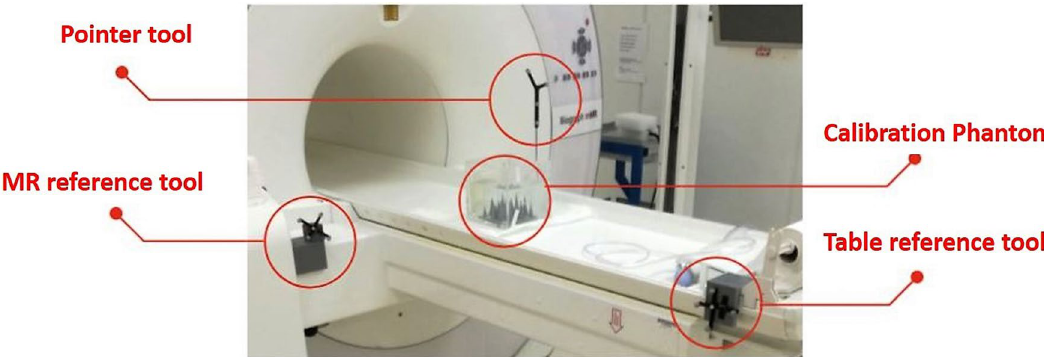
Figure 3. Set-up of the MR calibration. The coordinates of the calibraion phantom are measured respect to the ORF MR MR reference tool with a calibrated pointer tool. This enables to determine the transformation T MR from the MR-image coordinate system to the coordinate system of the optical tool mounted on the gantry of the using a calibrated stylus. In order to minimize the jitter-error from the stylus measurements, each of the seven cone tips were measured 10 times adjusting the relative camera position 10 times. Seventy points, acquired on a second multi-cone phantom, from independent ten images taken from different camera positions were used to compute the TRE. To increase accuracy we introduced an additional phantom calibration 19 . The coordinates of the cone tips were gathered in the coordinate system of the tank reference system as well as in the coordinate system of the CAD model of the phantom . This resulted in a transformation which was used to re-calculate the coordinates of the fiducials in the reference system from the more precisely measurable points in the CAD volume. For the TRUS calibration a point-to-point registration was applied as described in the 3D Slicer tutorial 20 . The TRUS transducer was mounted in a fixed position upon an empty water tank and a calibrated pointer was swept within the US image field of view (FOV). Tracker data were recorded automatically and the corresponding image coordinates were determined by marking at the maximum intensity profile of the pointer tip on the image for certain time points. The list of fiducials (15 fiducials on the 2D-TRUS image) given in the two coordinate systems (i.e. the image and the OTS coordinate system) were then used for the point-to-point registration. MR calibration. The MR calibration was carried out by a point-to-point registration to get the transformation ORF MR ) and the MR image ( MR ). To measure the coor- T MR ORF MR between the OTS reference coordinate systems ( dinates of the phantom tips with respect to the OTS two optical tracking tools were mounted rigidly on the MR gantry and on the MR table (see Fig. 3, labeled as ’MR reference tool’ and ’Table reference tool’, respectively). As with the 3D-US calibration, the tips of a multi-cone phantom with 18 cones served as fiducials. Each tip- fiducial was collected five times, without moving the camera. As it is not possible to collect the fiducials with the stylus when the phantom is placed in the field of view of the MR, a table shift is required. The cone tips were first recorded with respect to the Table reference tool, and second, the OTS tracked the table shift inside the MR gantry (transformation between the ORF TABLE and the ORF MR ). The coordinates of the tips with respect to the MR coordinate system were determined from the MR image data set.